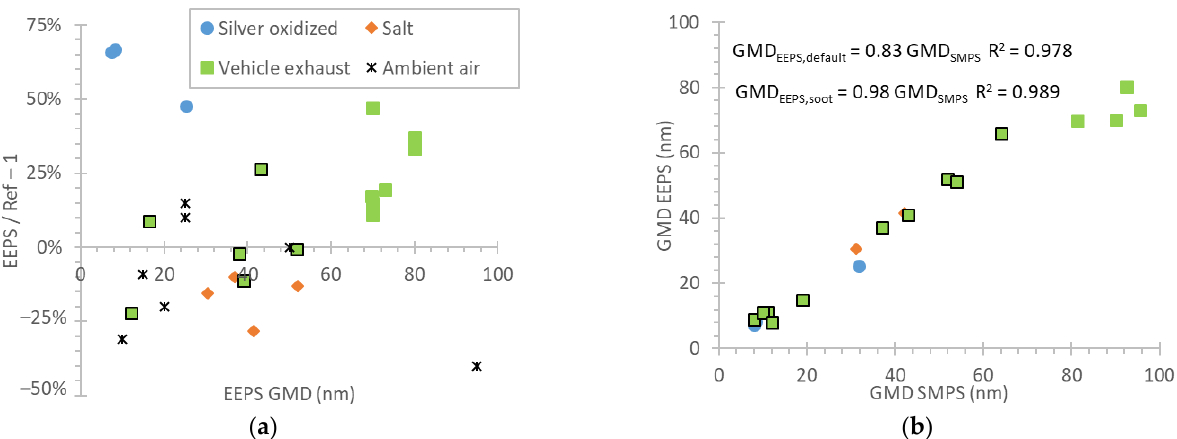
Figure 8. Overview of literature studies. ( a ) PN concentration ratio (EEPS to reference) in function of the reference instrument (CPC or SMPS) concentration; ( b ) Correlation between EEPS and SMPS: ( a ) geometric mean diameter (GMD). All studies used the “Default” EEPS matrix, except those with a black frame that used the “Soot” EEPS matrix. Data f rom: silver [83], salt [15,44,45,84,85], vehicle